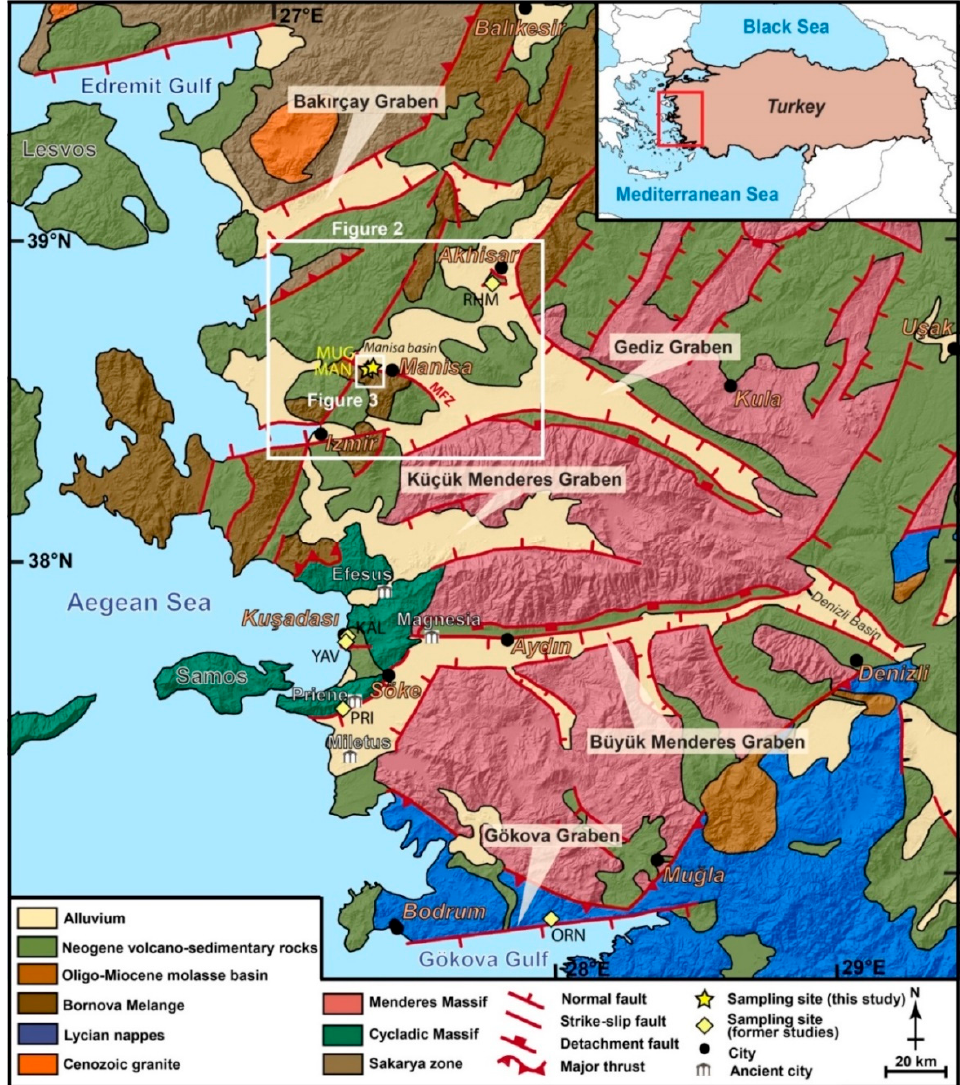
Figure 1. Simplified geological map of western Anatolia showing major structural elements and location of Manast ı r and Mug ı rtepe faults (modified from [24,33–34,41–42]). Inset white boxes mark the location of the Figures 2 and 3. Faults abbreviations: MFZ: Manisa Fault Zone, RHM: Rahmiye, MAN: Manast ı r, MUG: Mug ı rtepe, KAL: Kalafat, YAV: Yavansu, PRI: Priene-Sazl ı , ORN: Ören.